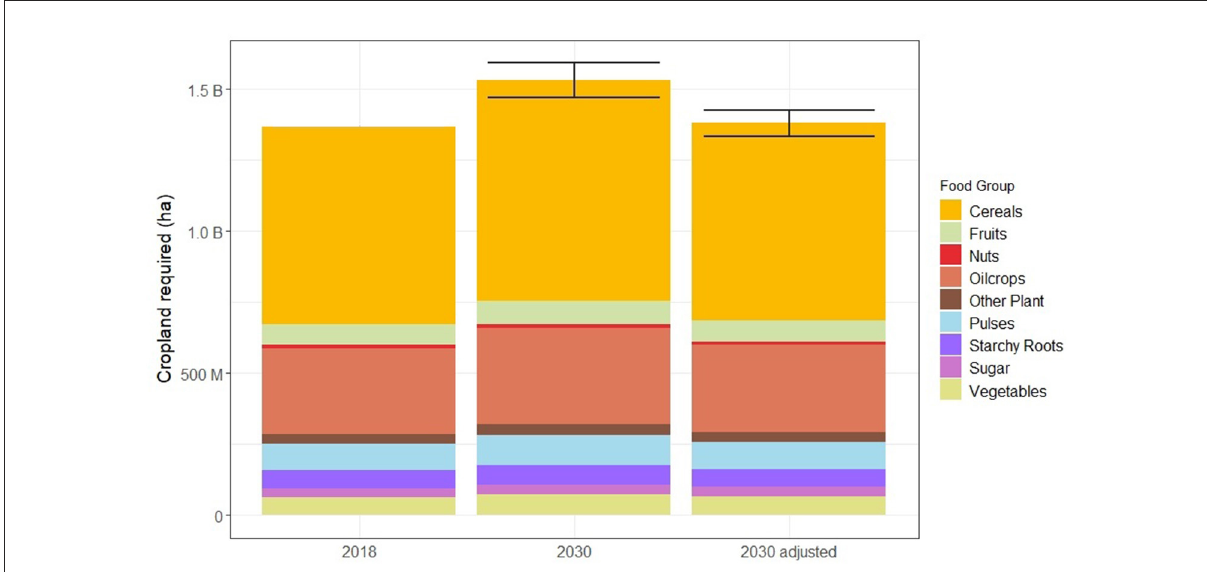
FIGURE4 Comparing cropland requirement in 2018 with two simulated scenarios. The 2030 scenario shows predicted cropland requirement if all crop production were to increase by 12%, to match the population increase from 2018 to 2030. The 2030 adjusted scenario is identical, but 30% of LY production has been improved to HY. Error bars indicate the upper and lower bounds of the